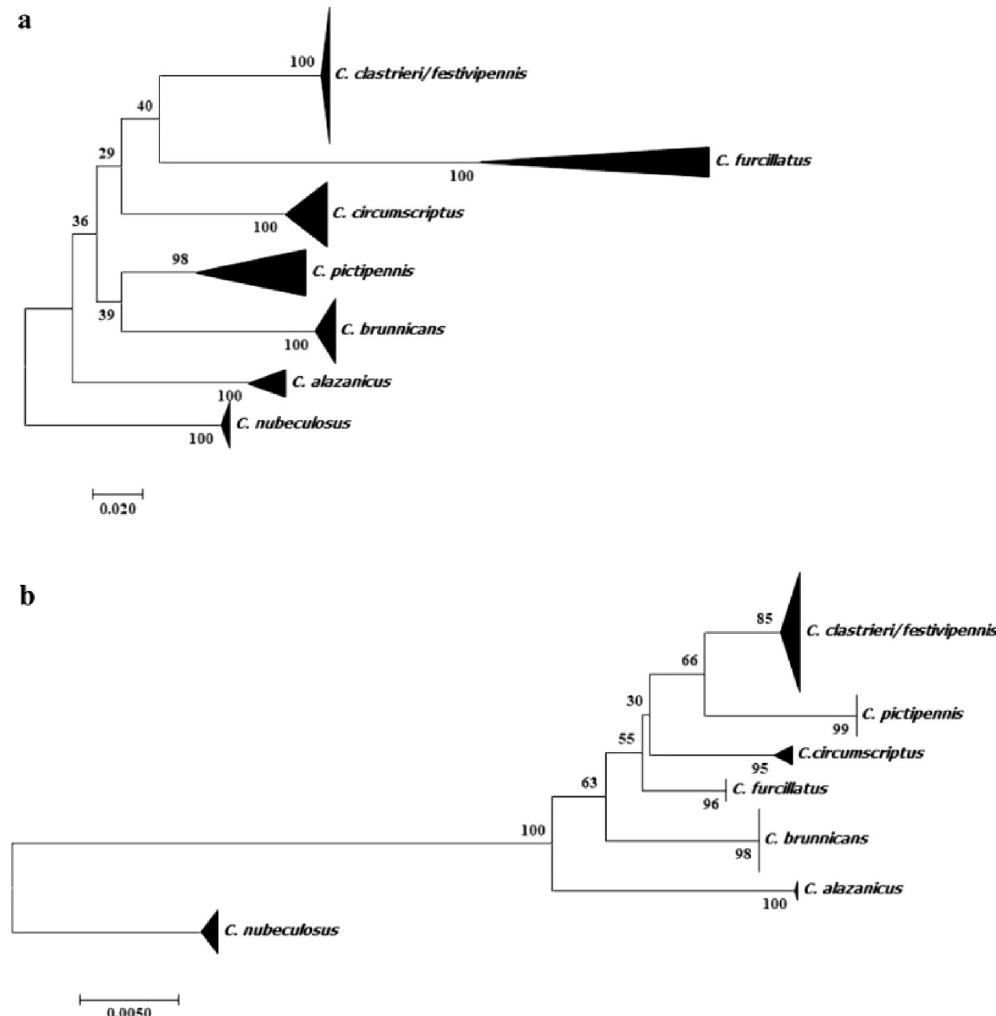
Figure 2. Trees obtained from nucleotide analysis of: ( a ) COI mtDNA; ( b ) 28S rDNA (with MP method) sequences of C. alazanicus, C. brunnicans, C. circumscriptus C. clastrieri, C. festivipennis, C. furcillatus, C. nubeculosus and C. pictipennis and bootstrap values are shown in nodes (1000